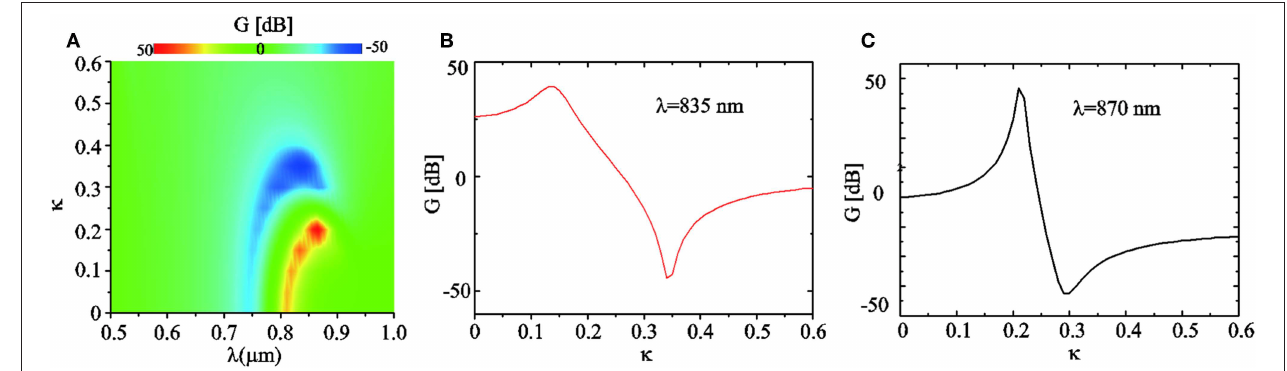
FIGURE 4 | Unidrectional scattering produced by the PT -symmeric structures. (A) The forward to backward ratio G as a function of κ and the wavelength. (B) G as a function of κ at λ = 835nm. (C) G as a function of κ at λ = 870nm.